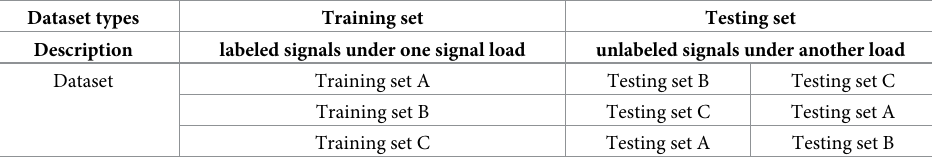
Table 2. Description of across different load domains